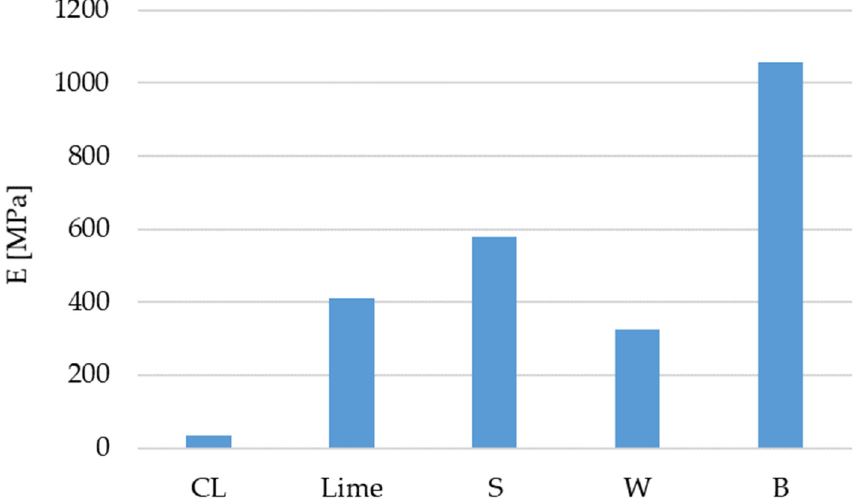
Figure 6. Results of modulus of elasticity test.